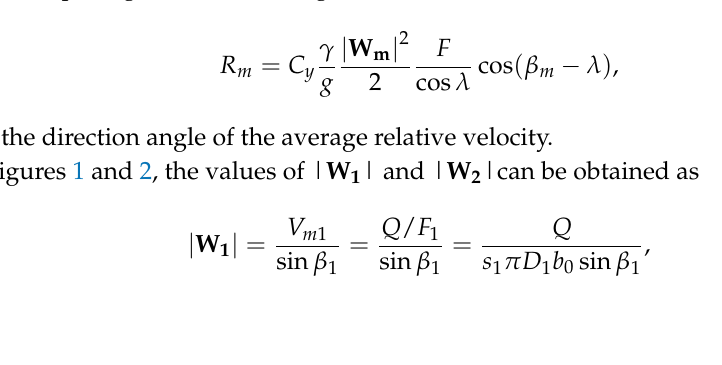
Figure 3. The force analysis for a single blade.